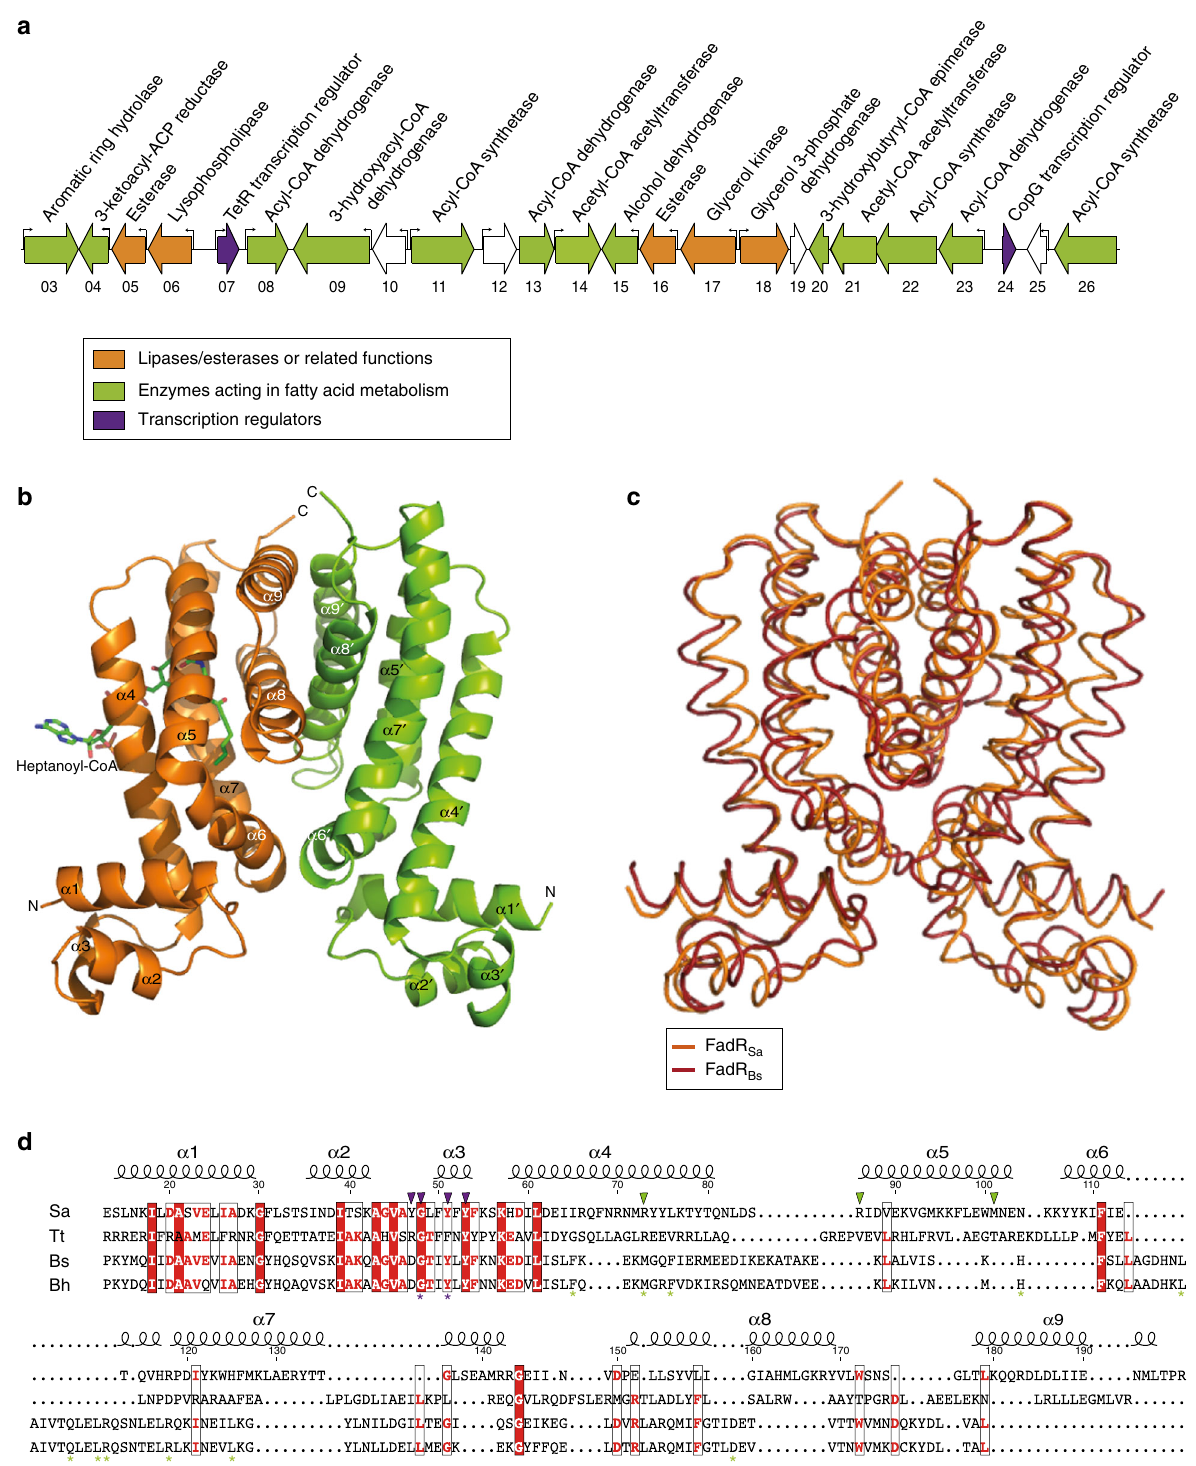
four experimentally identi fi ed binding sites, an in silico screening